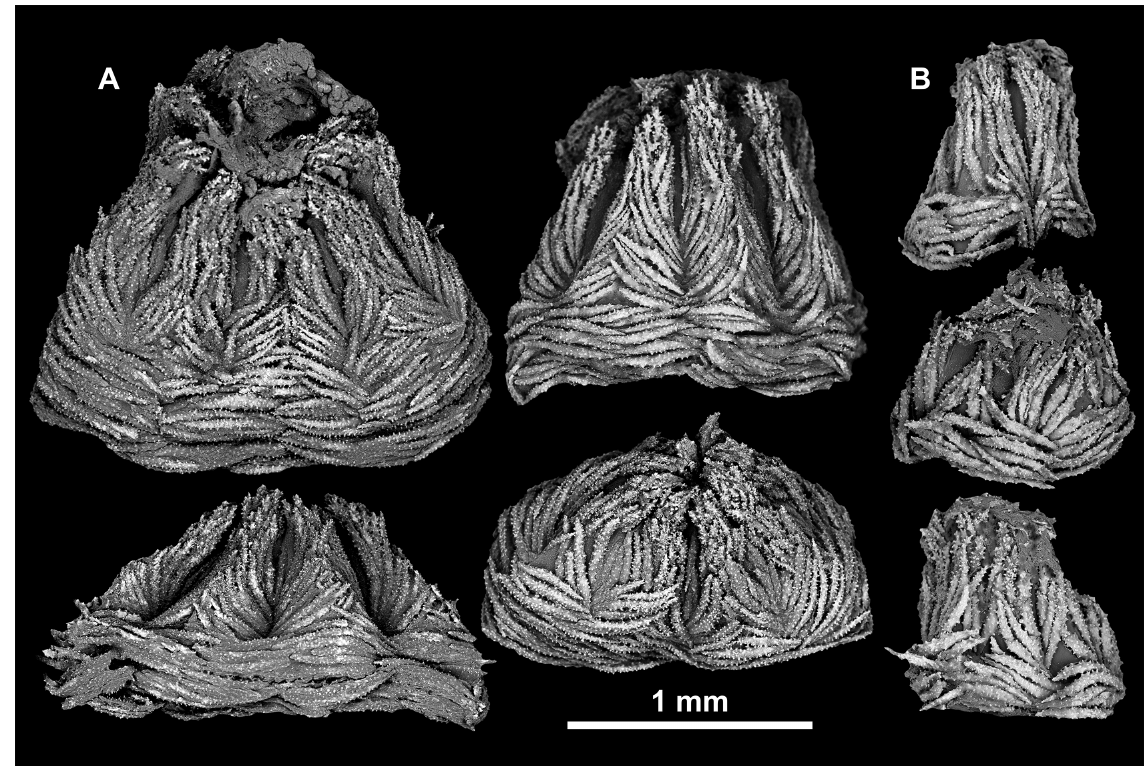
Fig. 34. SEMs of sclerites from polyps (in situ). A . Ushanaia fervens gen. et sp. nov., holotype (NIWA 156311). B . U. solida gen. et sp. nov., holotype (NIWA